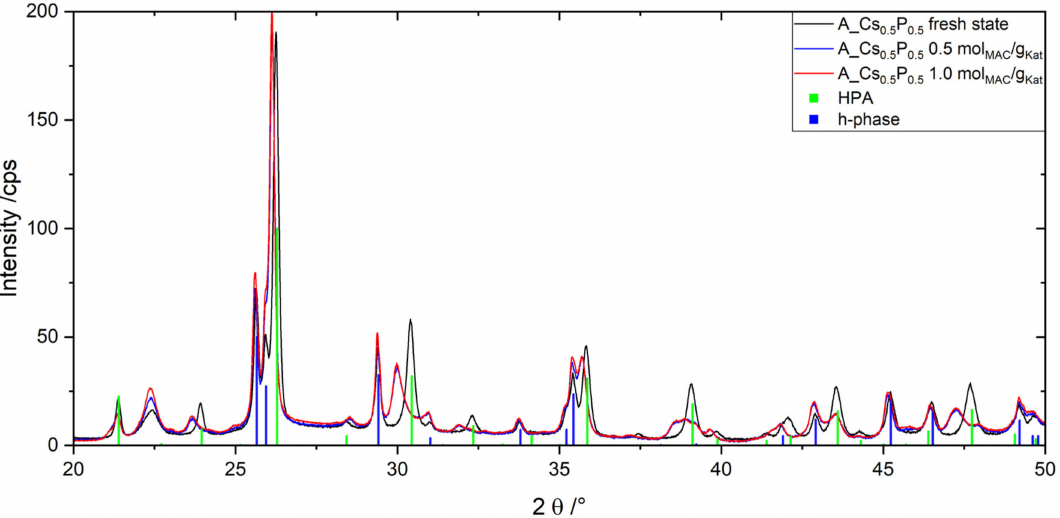
Figure 12. XRD pattern of A_Cs 0.5 P 0.5 for three cumulated amounts of converted MAC at an elevated temperature of 340 ◦ C. Characteristic XRD reflexes of h-phase (blue bars) and HPA (green